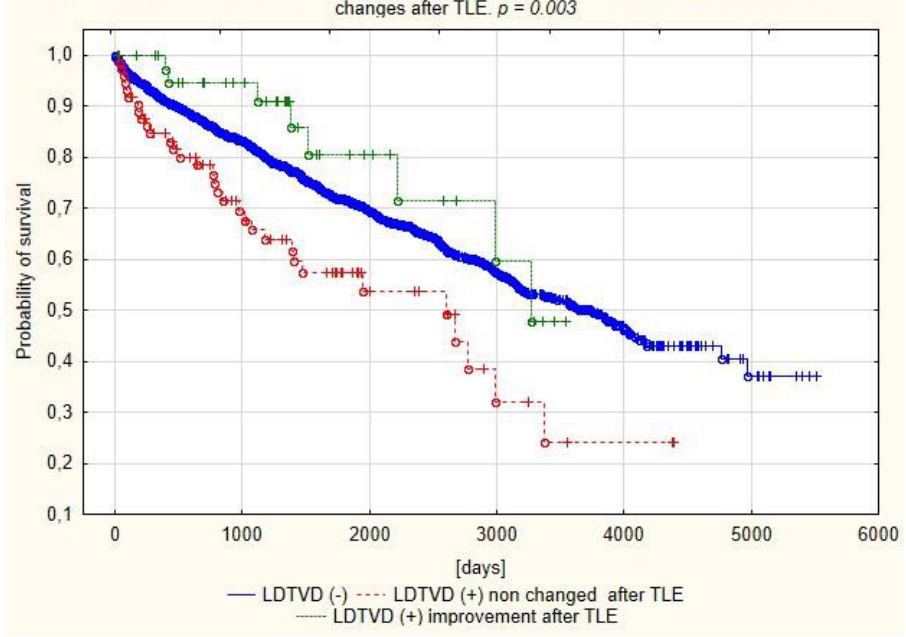
Figure 2. Kaplan – Meier curves of survival depending on the prevalence of LDTVD and changes Figure 2. Kaplan–Meier curves of survival depending on the prevalence of LDTVD and changes after TLE. after